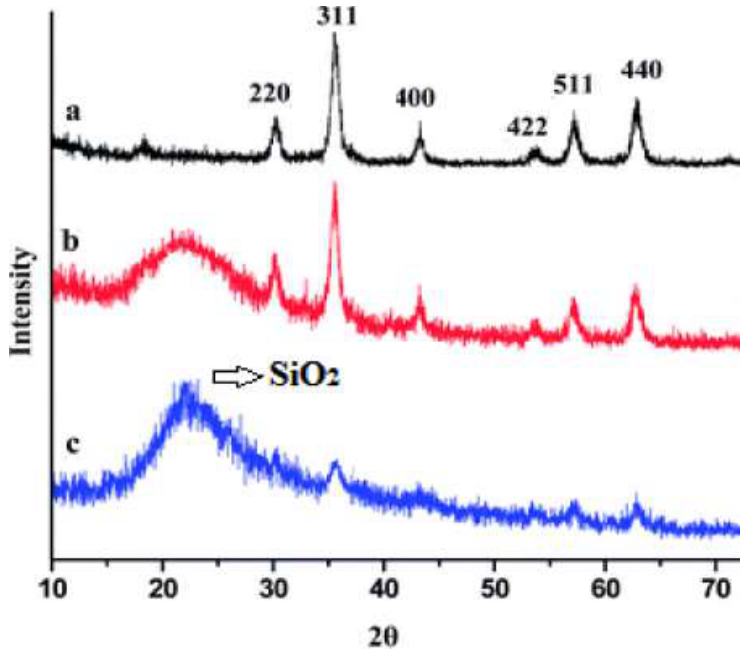
Fig. 2. XRD spectra of (a) pure Fe